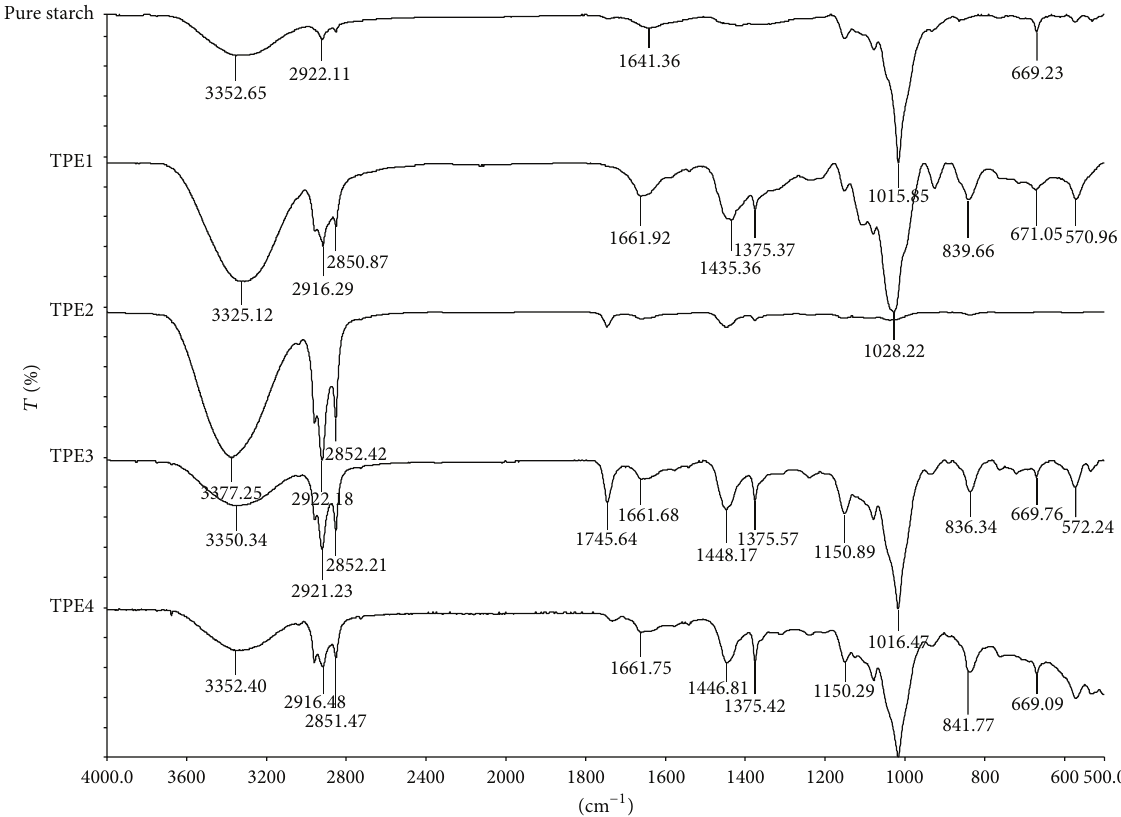
Figure 1: Chemical functional group of pure starch TPE1, TPE2, TPE3, and TPE4.